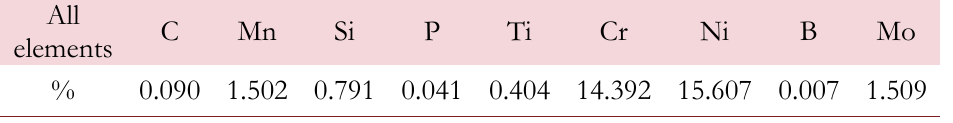
Table 1: Chemical composition of 15-15Ti(Si)